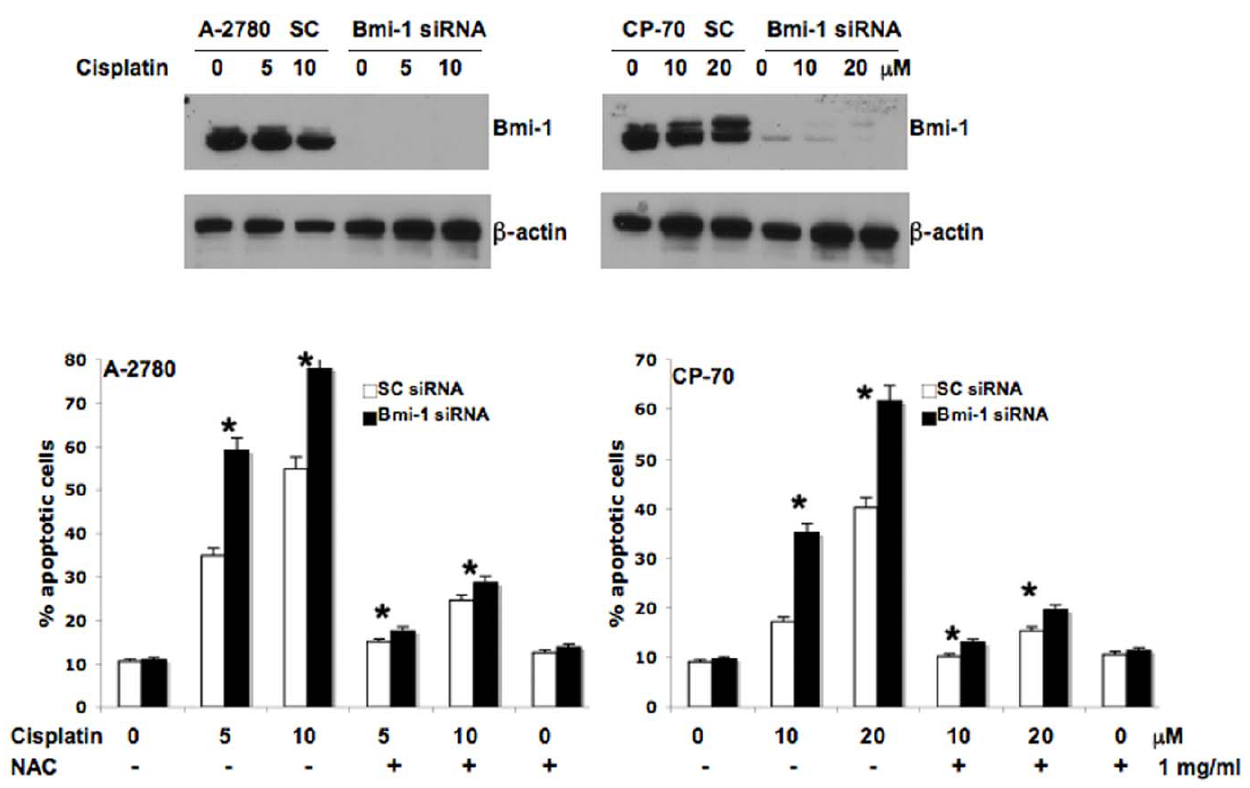
Figure 1. Bmi-1 knockdown sensitizes ovarian cancer cells to cisplatin through ROS pathway. The top panel demonstrates efficient knockdown of Bmi-1 by siRNA in the ovarian cancer cell lines (SC=scrambled control siRNA) as determined by Western blot. The bottom panel demonstrates percent apoptosis as determined by Annexin/FITC-PI staining. Ovarian cancer cells transfected with scrambled control or Bmi-1 siRNA were treated with or without cisplatin for 48 h. NAC pre-treatment was done for 1 h before addition of cisplatin where appropriate.